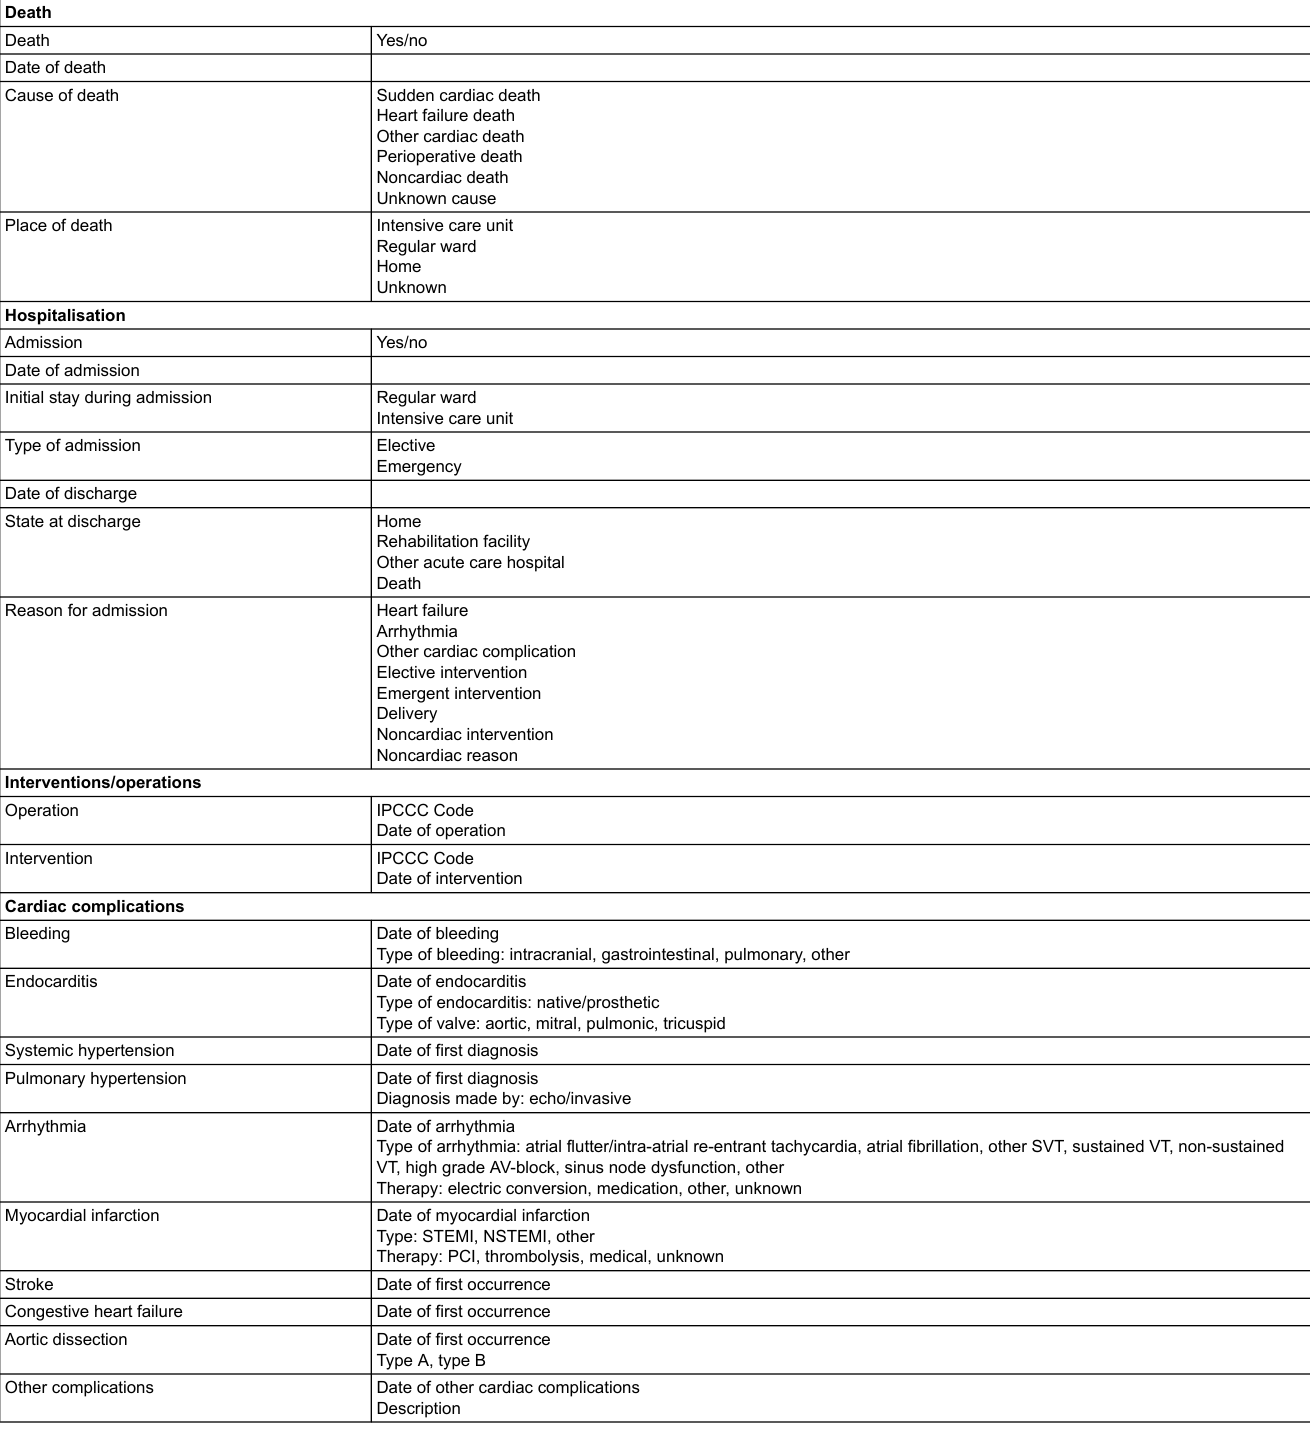
Table 3: Case report form for cardiac